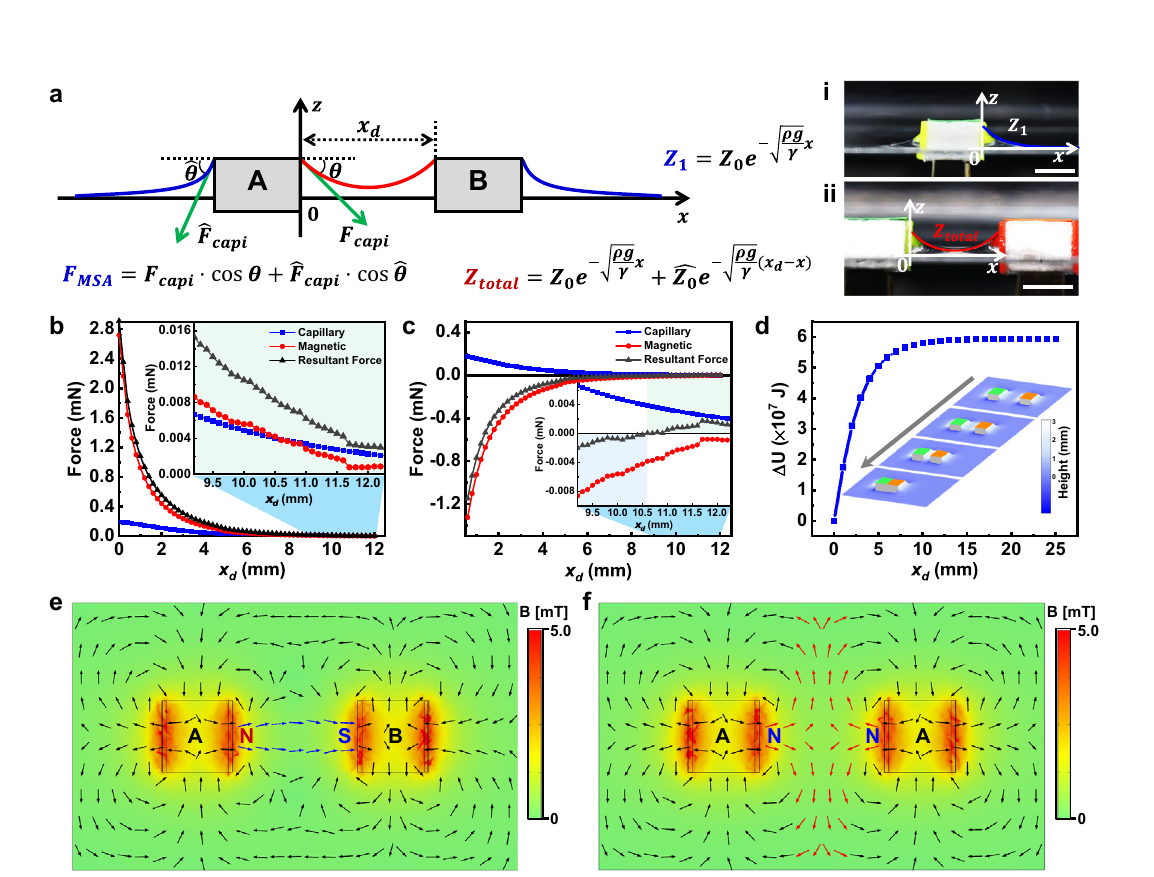
Fig. 3 | Calculations and simulations of capillary and magnetic forces. a Capillary forces induced bysingle ( ^ F capi )and merged ( F capi ) menisciatthethree- phase-contacting lines dependent on the angles ( ^ θ and θ ) between the according menisci and the horizontal direction as the interactive distance ( x d ) changes; the resultant lateral force for assembly is F MSA . The height functions of Z ð x Þ to display the meniscus contours ( Z 1 : single meniscus; Z total : merged meniscus) depending onthedensity( ρ ),surfacetension( γ )oftheliquid,theoriginalmeniscusheight( Z 0 = ^ Z 0 =3 mm ) at x =0; g is the gravitational acceleration. The calculated/simulated